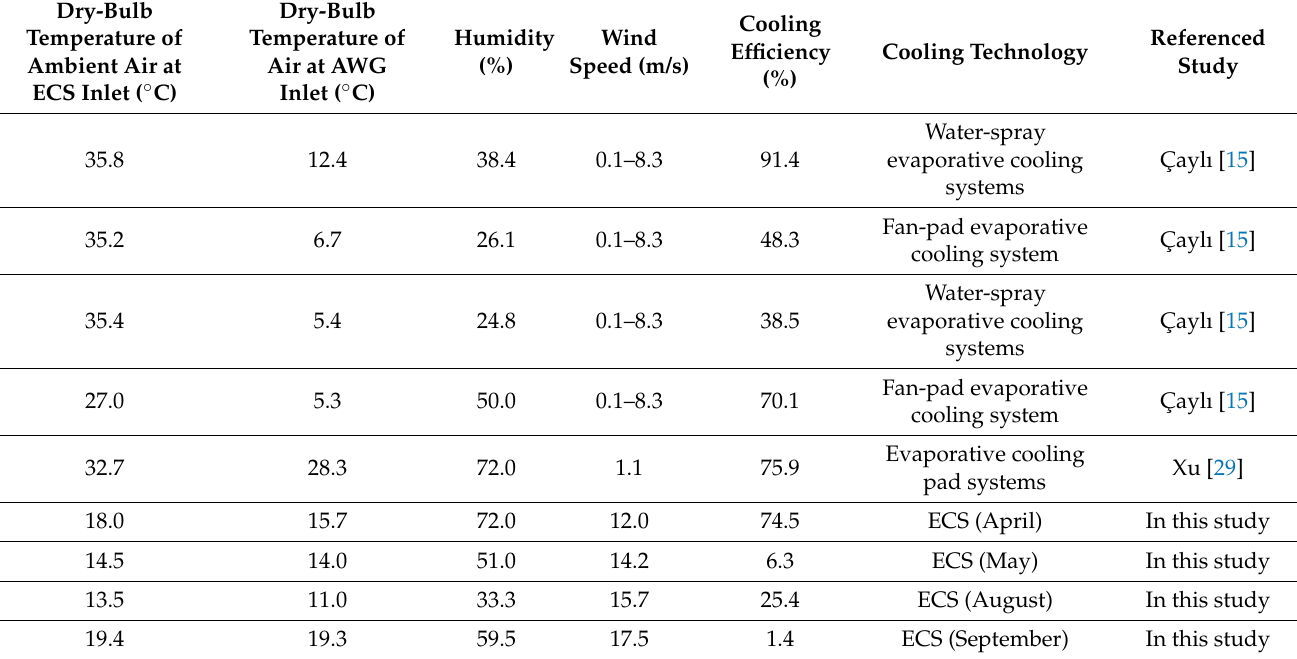
Table 3. Comparison of ECS performance in evaporative cooling